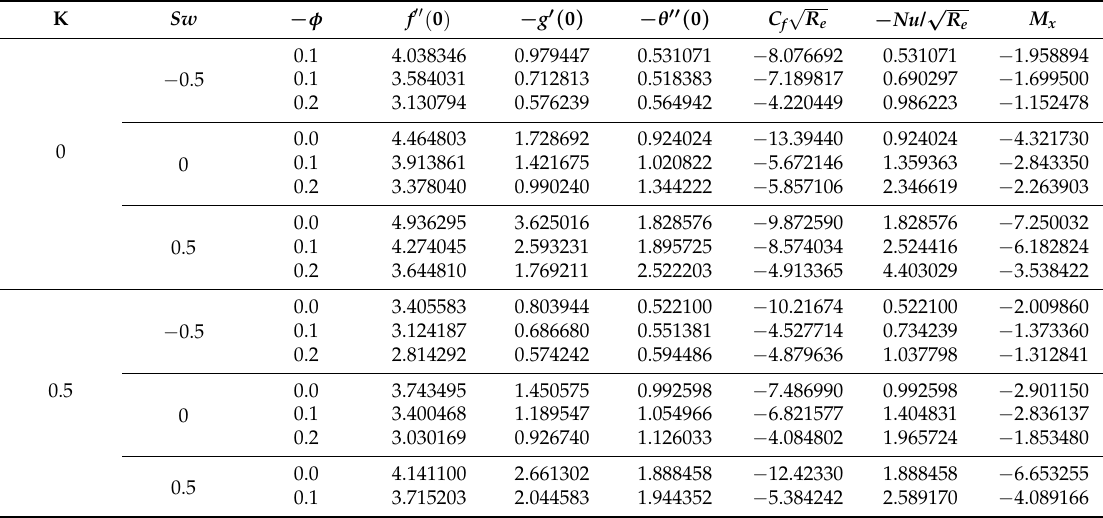
Table 3. Values of − f (cid:48)(cid:48) ( 0 ) , − g (cid:48) ( 0 ) , and − θ (cid:48) ( 0 ) for the steady case [ A = 0] at R = 1, Prandtl number ( Pr ) = 6.2, M = 0.1, kp = 0.1.